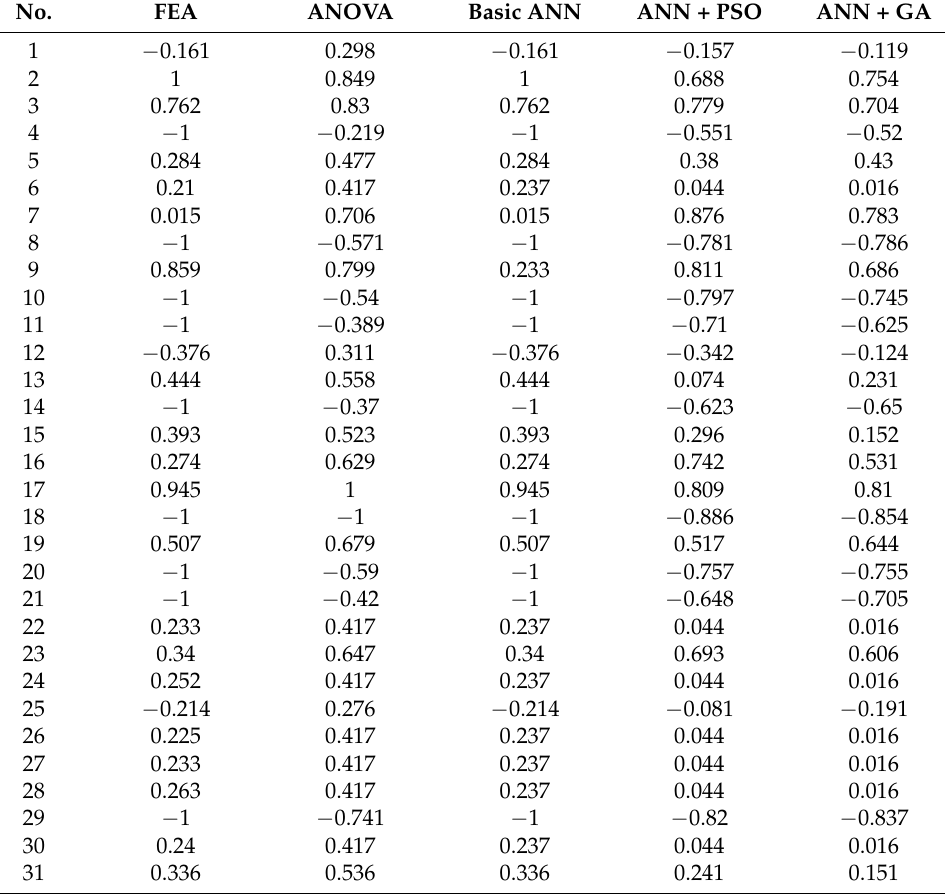
Table 8. Comparison of normalized values predicted by ANOVA, ANN Algorithms, and